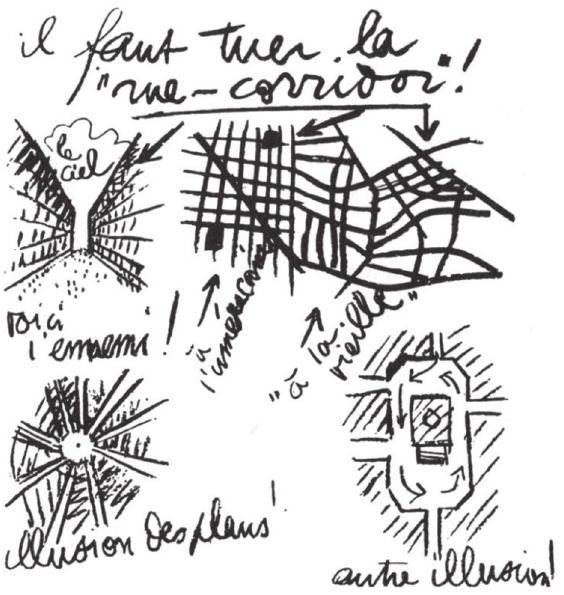
fig. 8. “Il faut tuer la ‘rue-corridor’!” (le Corbusier